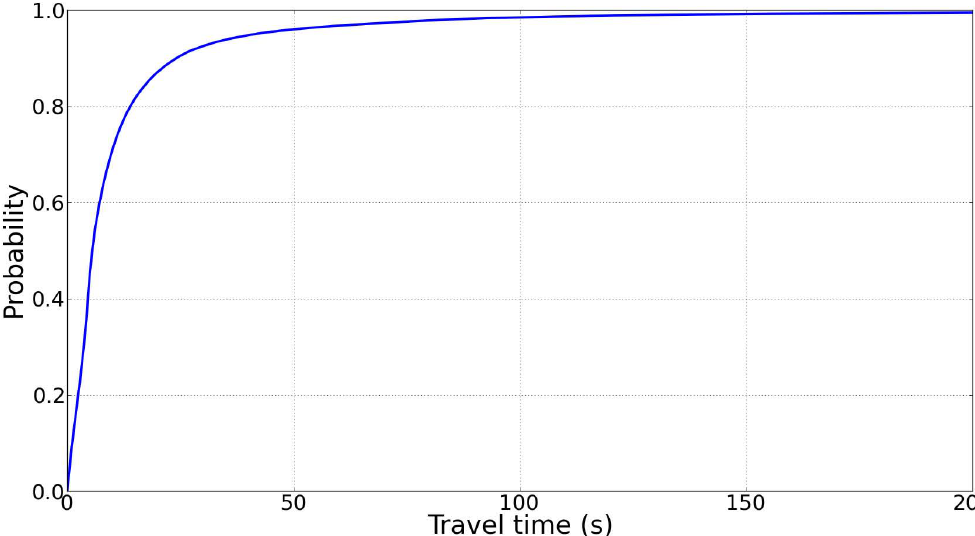
Figure 7. The cumulative distribution function of movement durations for a speed threshold of 0.4 m/s. The minimum movement duration is around 5